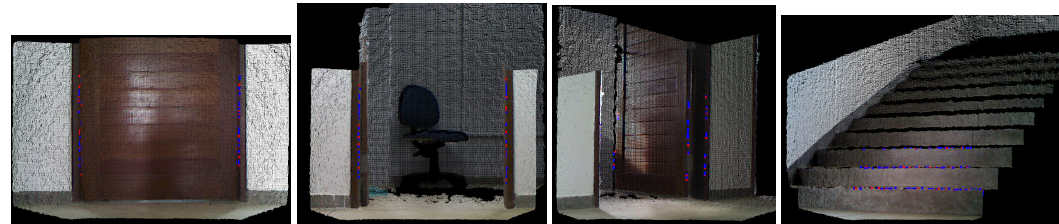
Figure 4. Results from the filtering sub-steps. Here, four cases of observation can be seen: closed door (far left), an open door (middle left), an open door with a vision of 45 ◦ (middle right) and a staircase with a vision of 45 ◦ (far